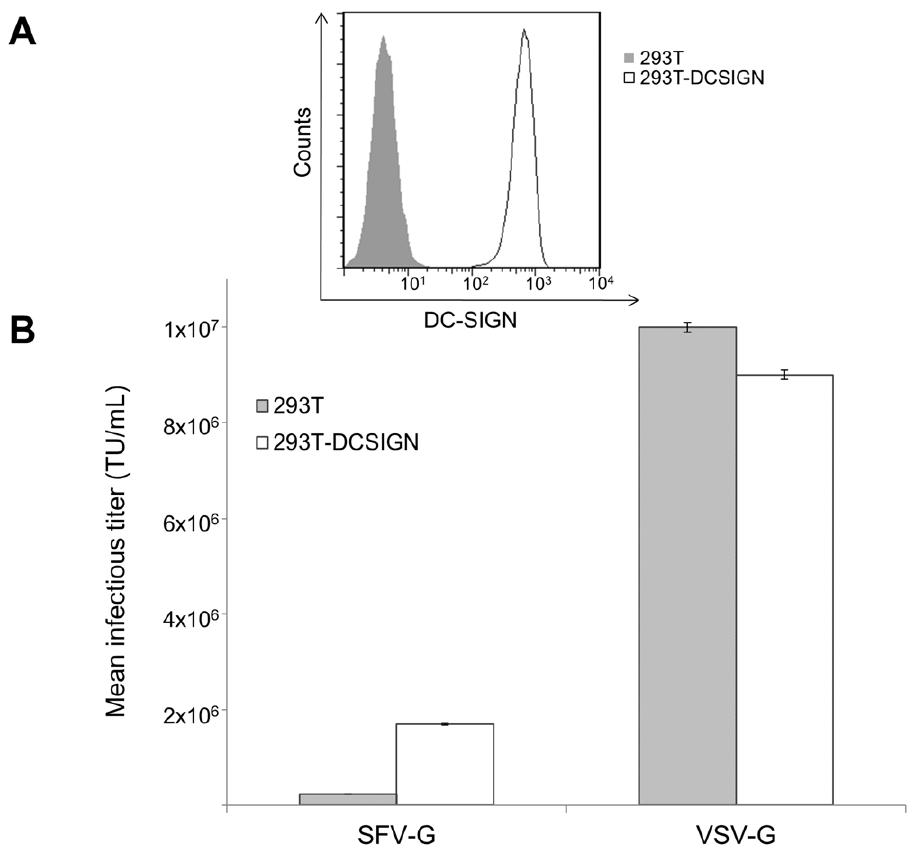
Figure 2. Lentiviral transduction of DC-SIGN-expressing 293T cells. (A) Expression of DC-SIGN in 293T (solid fill) and 293T.DCSIGN (open fill) was detected by flow cytometry. (B) Transduction titer of lentiviruses were quantified by serially diluting fresh viral supernatants of FUGW/SFVG and FUGW/VSVG and used to transduce 2 6 10 4 293T.DC-SIGN (open bars) or parental 293T cells (solid bars). Three days later, the transduction efficiency was measured by analyzing GFP expression using flow cytometry where the corresponding viral titer was calculated. Values are given as the mean of triplicates 6 S.E.